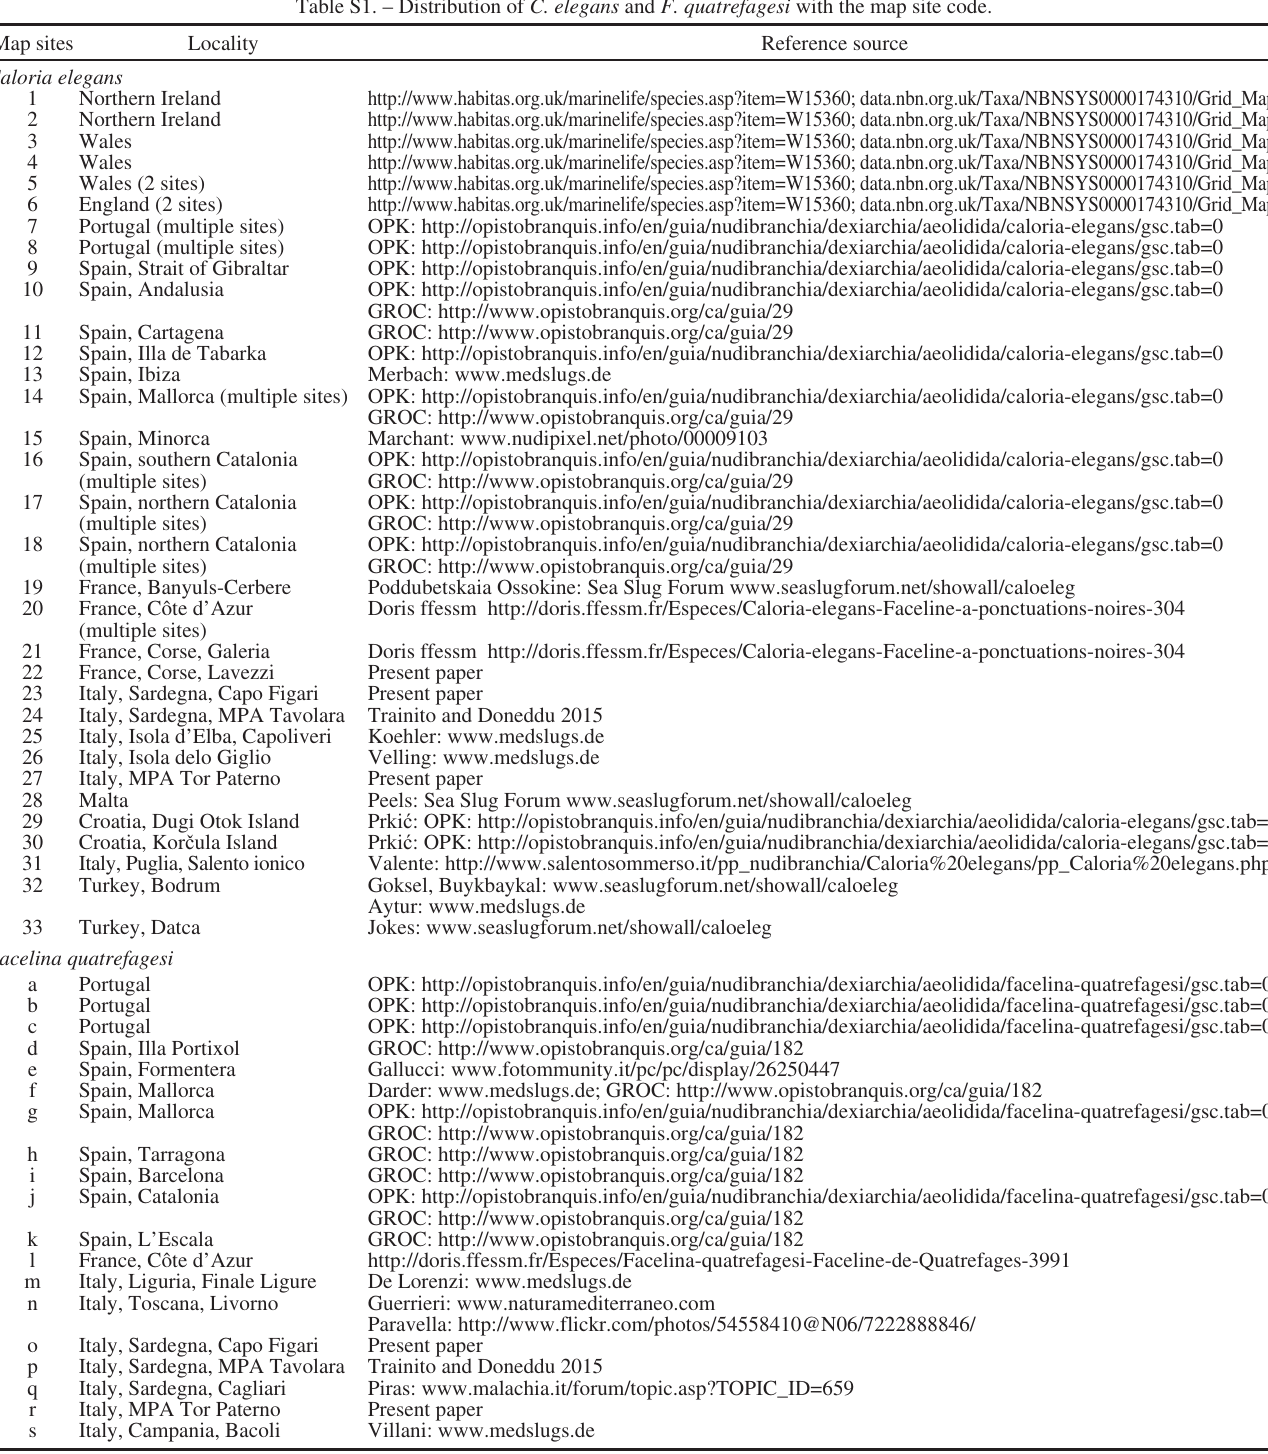
Table S1. – Distribution of C. elegans and F. quatrefagesi with the map site